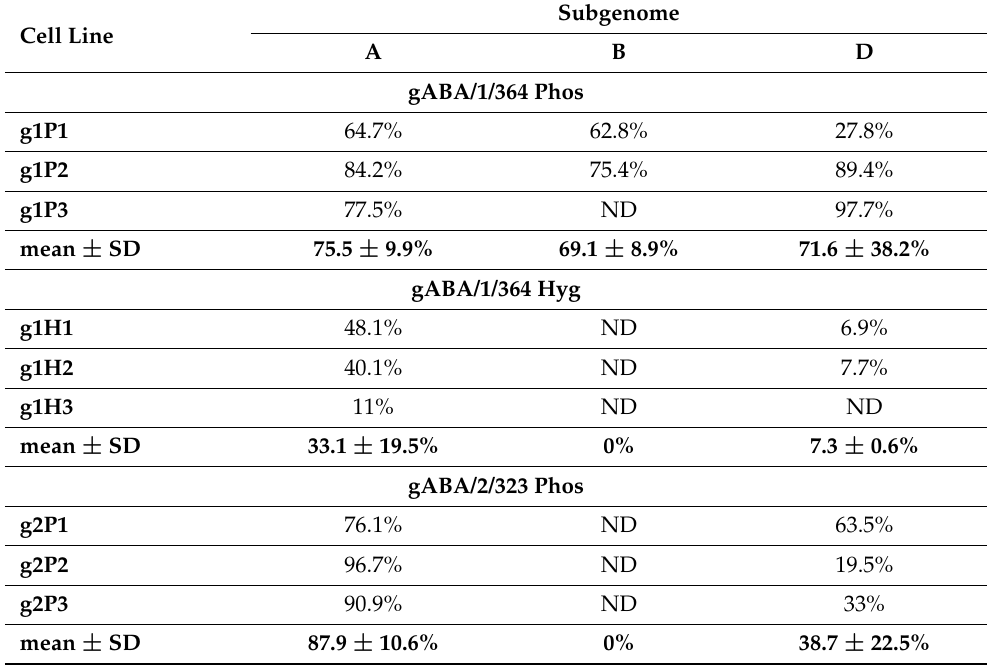
Table 1. Editing efficiency of on-target modifications in the selected wheat cell lines for three tested gRNA genetic constructs on respective wheat subgenomes (A, B, D). ND—editing not detected, Phos—phosphinothricine, Hyg—hygromycin